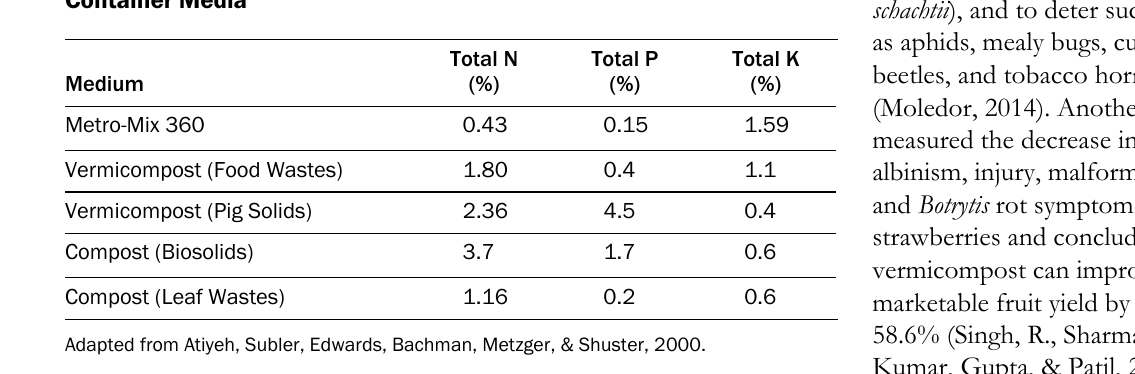
Table 1. Nitrogen (N), Phosphorous (P), and Potassium (K) Content of Container Media